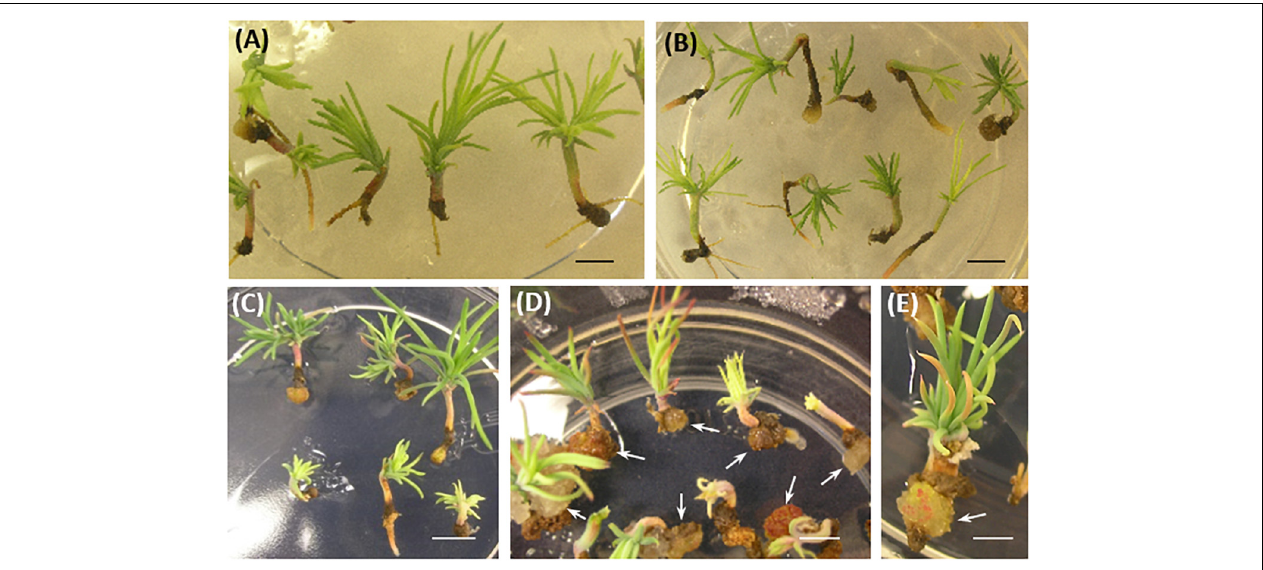
FIGURE 5 | P. pinaster somatic seedlings from 35S::PpWOX2 transgenic lines and controls (EV-pC05, WT) after 8–10 weeks in conversion medium. (A) WT and (B) EV-pC05 somatic seedlings with similar and normal phenotype. The root growth of somatic seedlings from the 35S::PpWOX2 lines was reduced (C,D) and ultimately affected SE viability and behavior. Note the formation of callus in the root region of line #15 [ (D,E) , arrows] compared to the WT and EV-pC05 controls (A,B) . Scale bars: (A) 2 mm, (B–D) 3 mm, and (E) 1 mm.